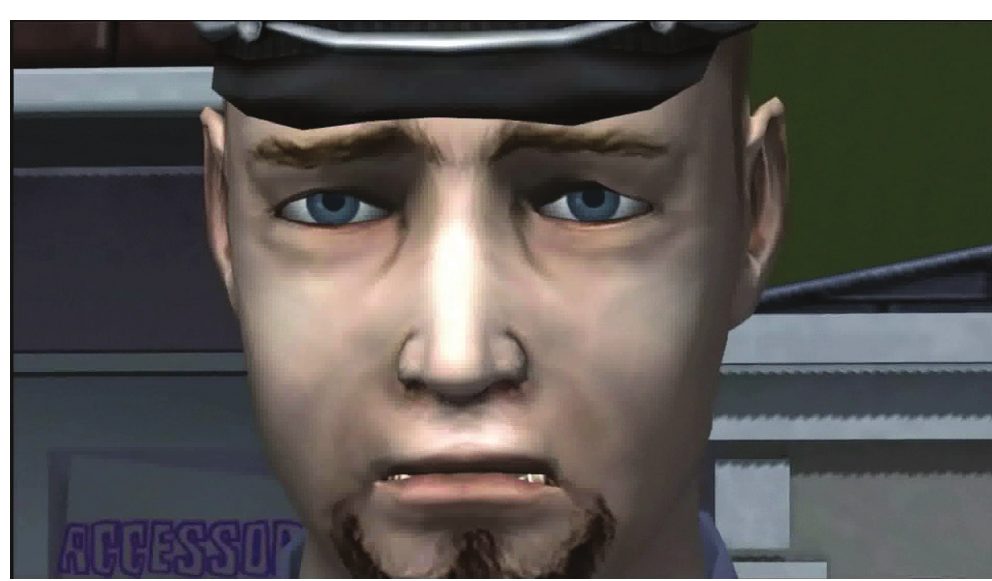
Figure 3: Screengrab of policeman sequence in children’s machinima